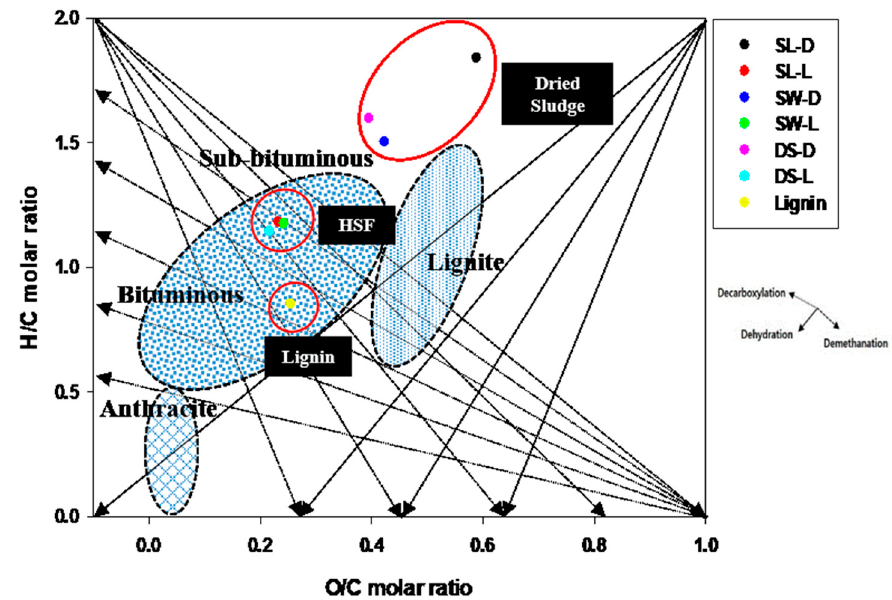
Figure 1. H / C and O / C molar ratios on van Krevelen diagrams for bioethanol-lignin, dried sewage sludge, and HSF samples (comparison of anthracite, bituminous, sub-bituminous, and lignite coals).